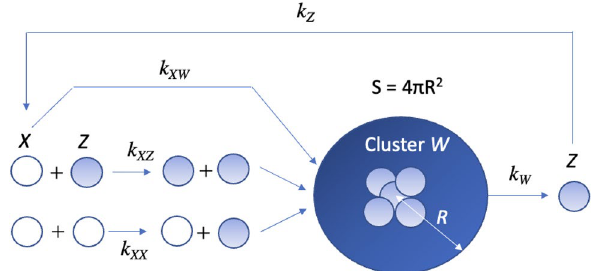
Figure 1. Scheme of infection transmission. Individual globules represent an “Exposed” X , an “Infectious” Z, and “Cluster” W . The recovery factor P supply is kept constant, and Z is released continuously from W . The differential equations are given in Eqs. (20)–(22). R indicates the cluster size. k XW , k Z , k WZ , k XX , and k XZ represents the kinetic coefficients in Eqs.